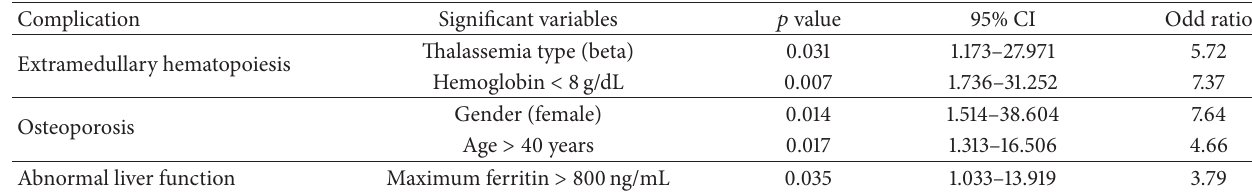
Table 5: Significant risk factors affecting complications from multivariate